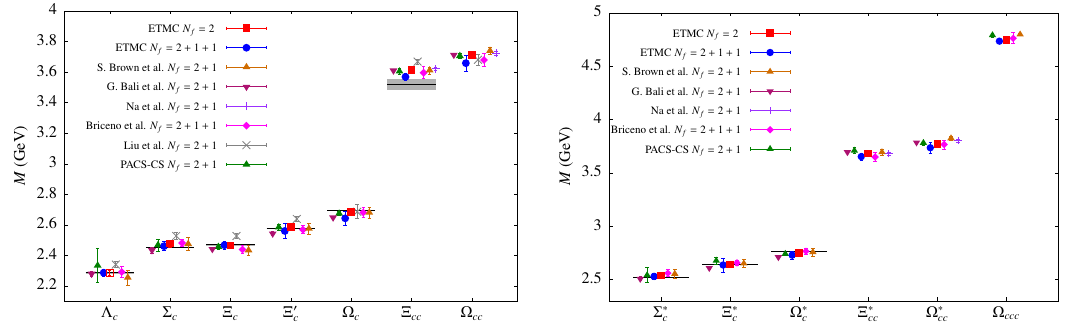
was correctly predicted cc is c